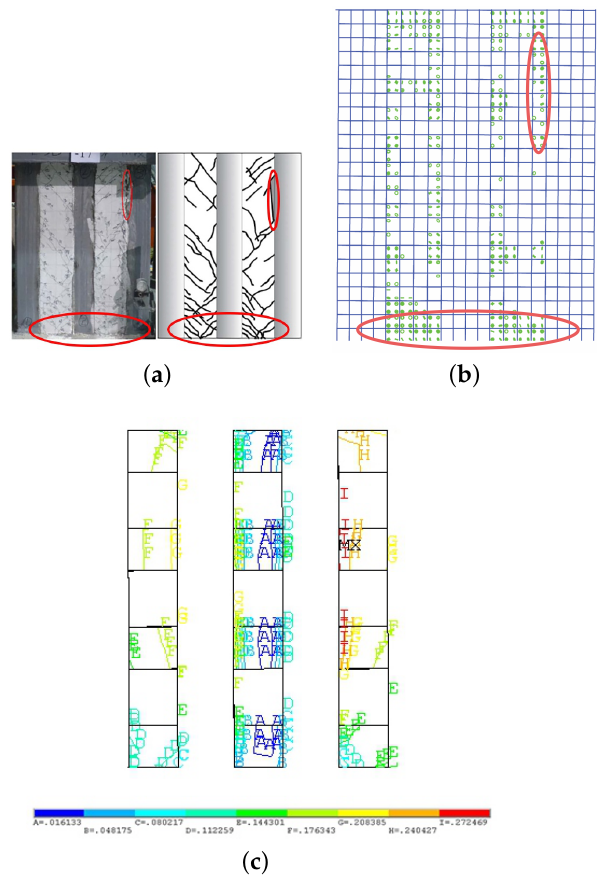
Figure 7. ( a ) Crack pattern observed experimentally in the structure [15], ( b ) cracks predicted numerically, and ( c ) contact sliding